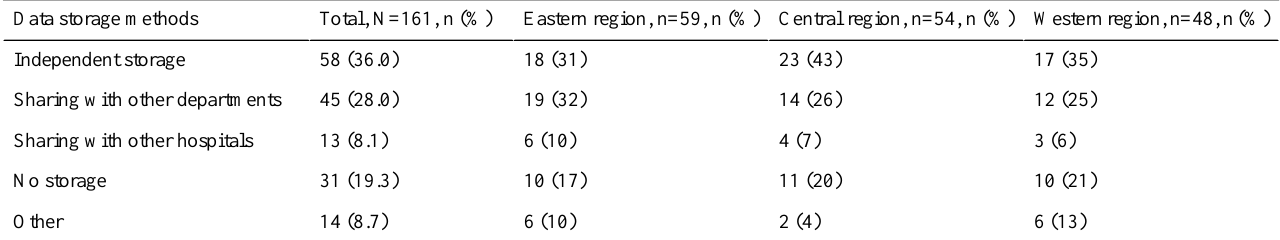
Table 4. Telemedicine data storage methods of tertiary hospitals in different regions of China (N=161).